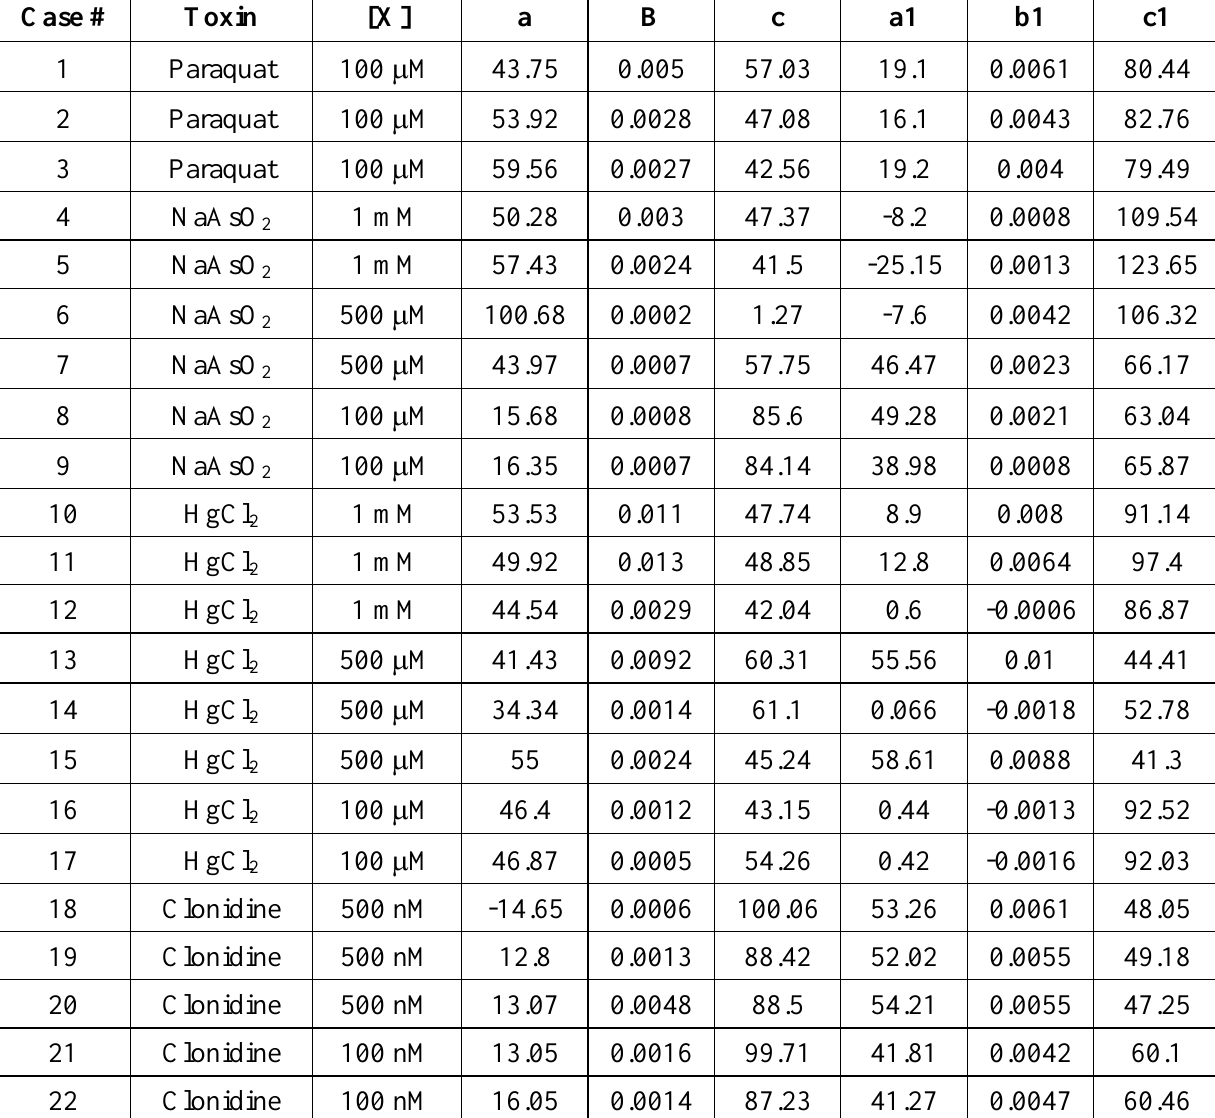
Table 1. Summary of the data included in the Linear Discriminant Analysis. The table includes explanatory variables a, b and c obtained from linear regression of the fish chromatophore experiments and the explanatory variables a1, b1, c1 obtained from the algal cell